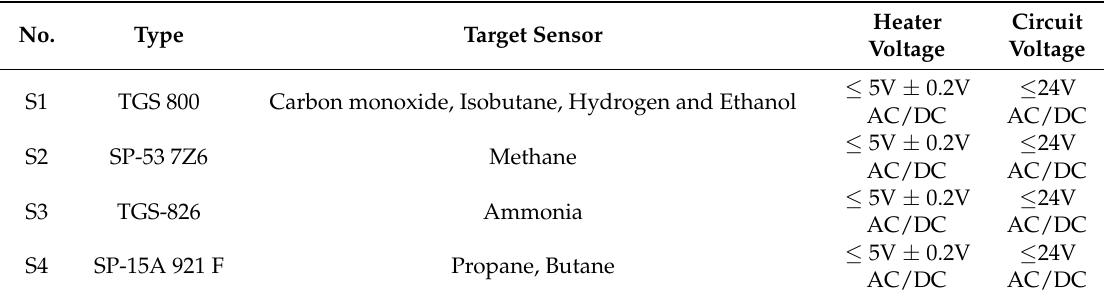
Table 1. Metal-oxide gas sensors.